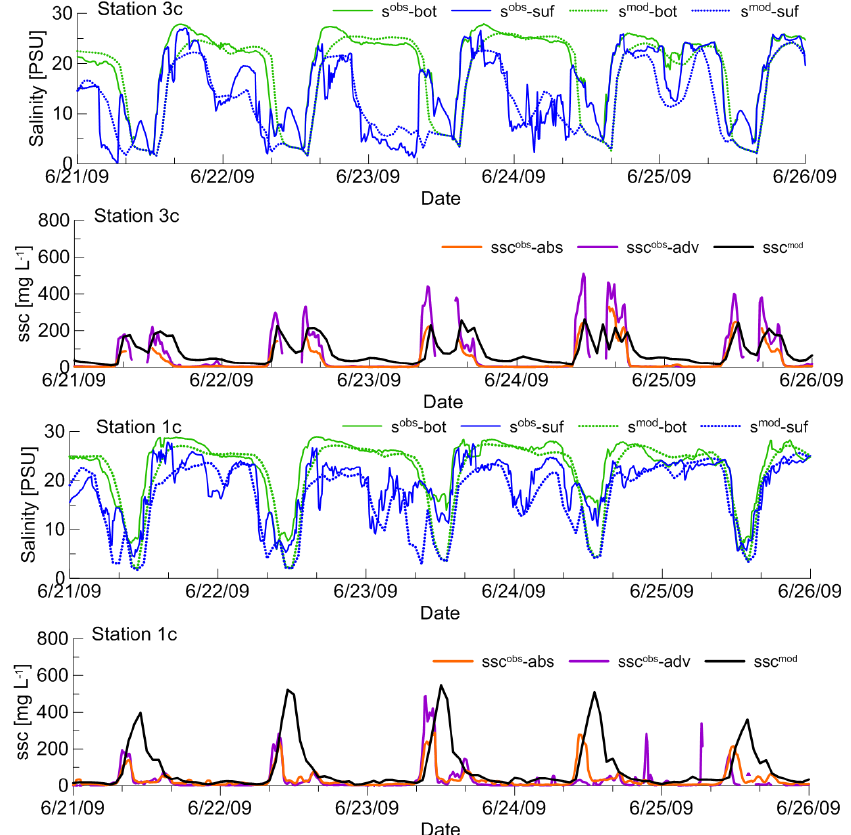
Figure 7. Comparison of observed salinity ( s obs -bot = observed bottom salinity, s obs -suf = observed bottom salinity, s mod -bot = modeled bottom salinity and s mod -suf = modeled surface salinity) and SSC ( ssc obs -abs = observed acoustic backscatter sensor suspended sediment, ssc obs -adv = observed acoustic Doppler velocitymeter suspended sediment and ssc mod = modeled suspended sediment) in Skagit tidal flats at stations 3c and 1c.